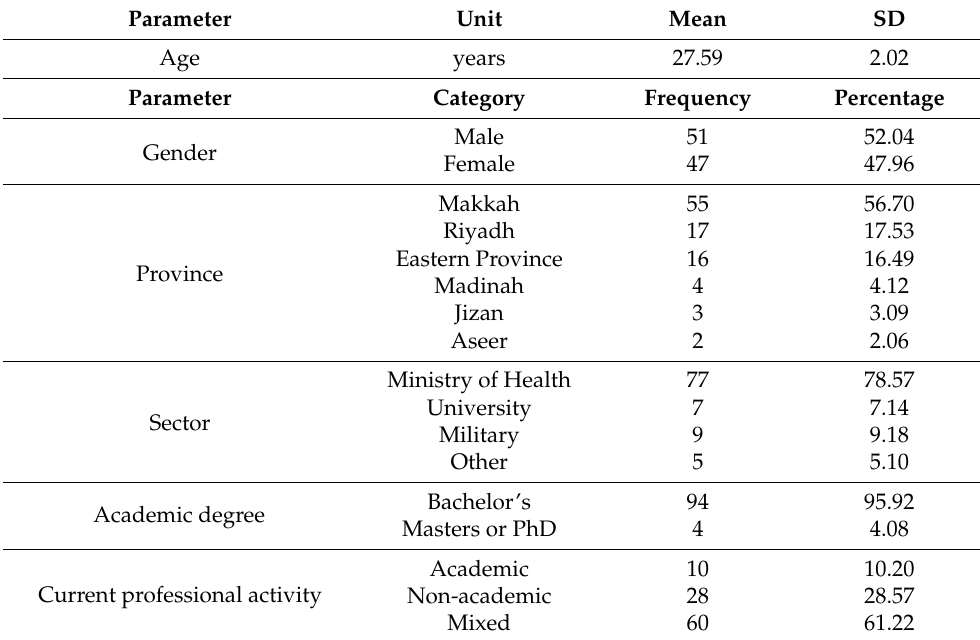
Table 1. Participants’ demographic and professional characteristics ( n = 98).